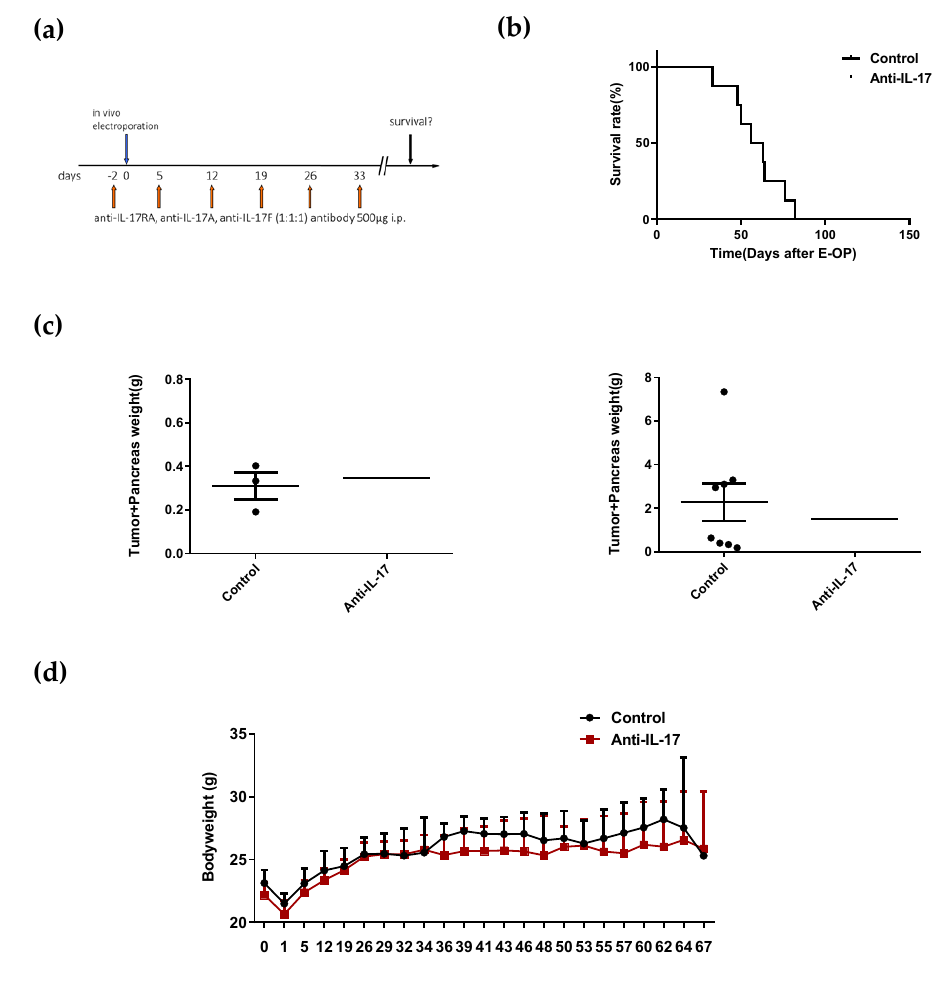
Figure 3. Blocking IL-17 does not a ff ect the survival in a mouse model of PDAC. ( a ) Experimental setup: Animals received anti-IL-17 antibodies on days − 2, 5, 12, 19, 26, and 33. In vivo electroporation to induce pancreatic cancer was performed on day 0. ( b ) Mice survival (%) of the control group ( n = 8) vs. anti-IL-17 treatment group ( n = 11). ( c ) Tumor weights (including the weight of the pancreas) on day 35 ( n = 3, left) and endpoint ( n = 6, right). ( d ) The curve of body weight from the control and anti-IL-17 treatment group was recorded to monitor the potential side effect.